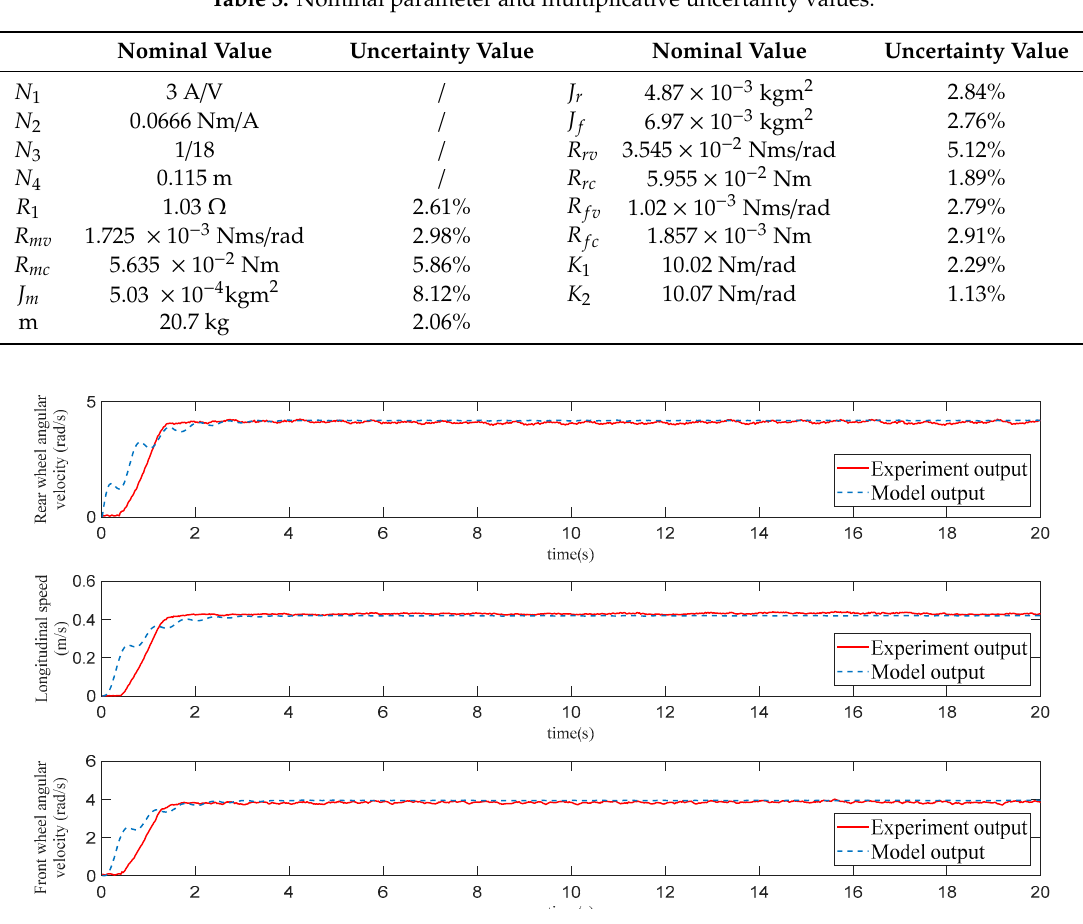
Table 3. Nominal parameter and multiplicative uncertainty values.